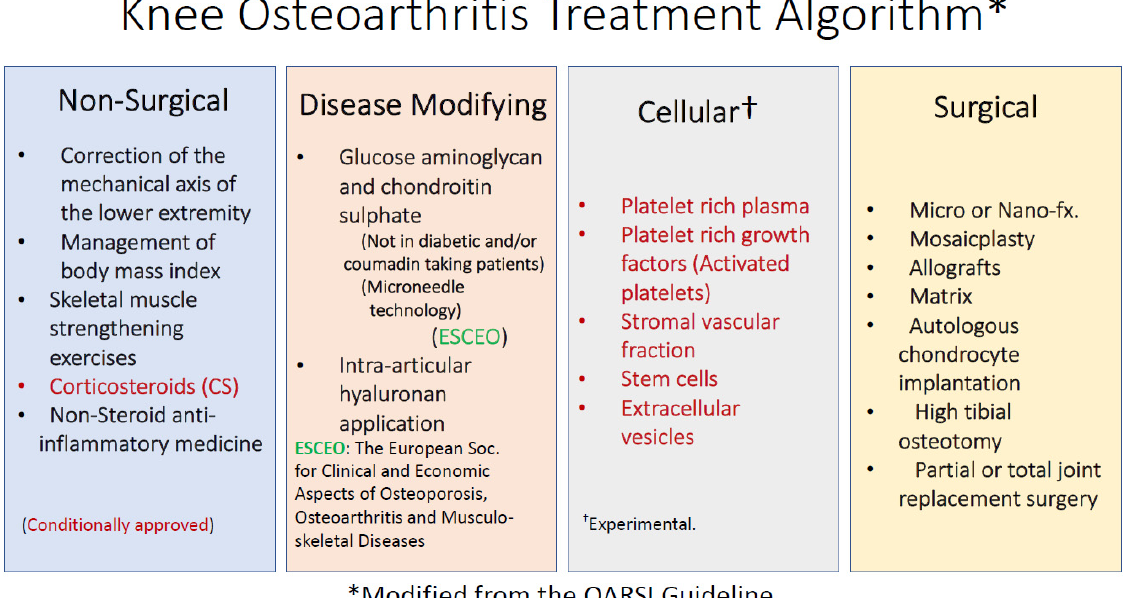
Figure 2. Knee osteoarthritis treatment algorithm (Modified from OARSI).